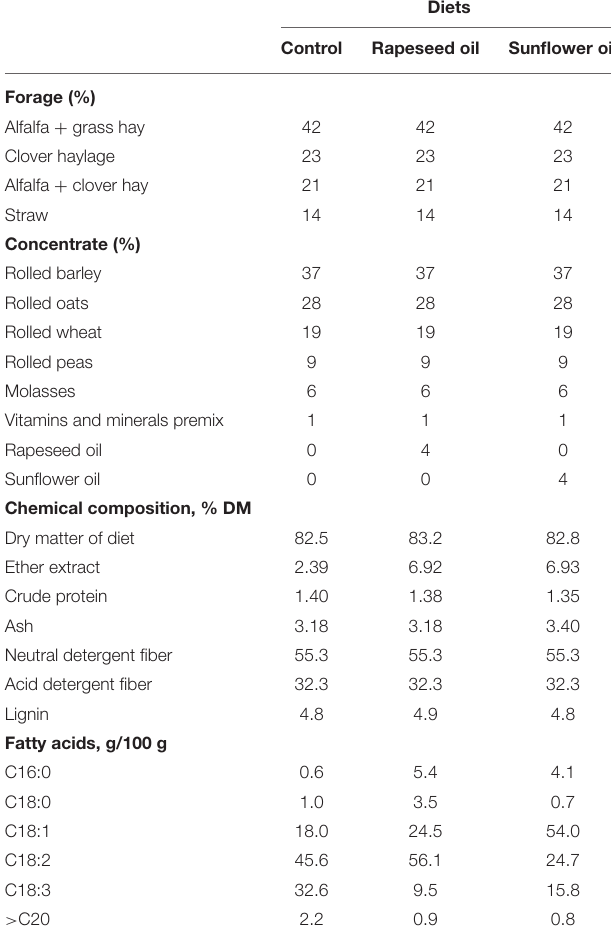
TABLE 1 | Diet and treatments